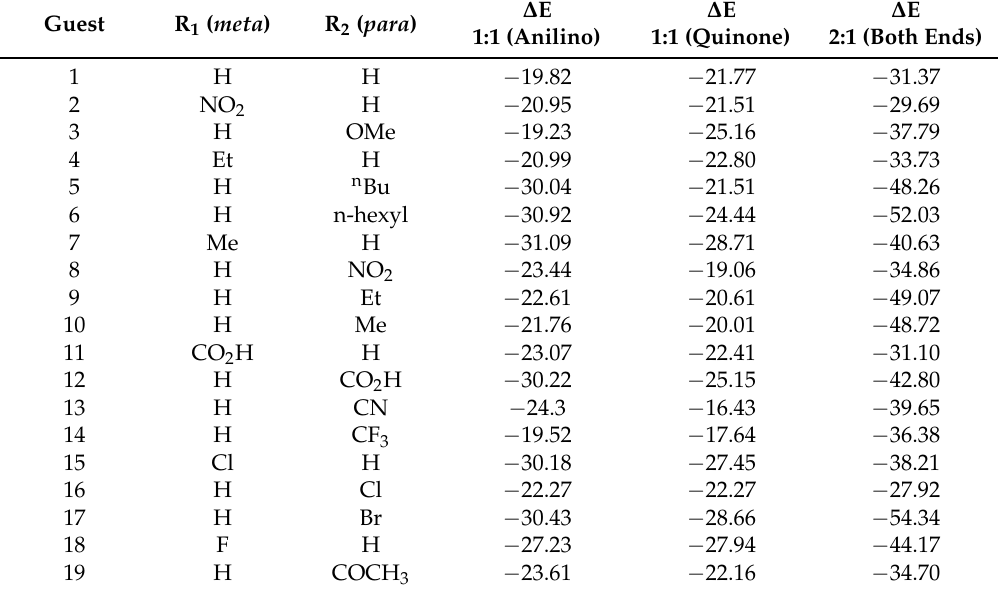
Table 2. Molecular modeling calculations for the energy stabilization upon complexation ( ∆ E, in kcal/mol) for the inclusion of the 19 PAN derivatives, as 1:1 (anilino encapsulation), 1:1 (quinone encapsulation), or 2:1 (both ends encapsulated) complexes. Guest R 1 ( meta